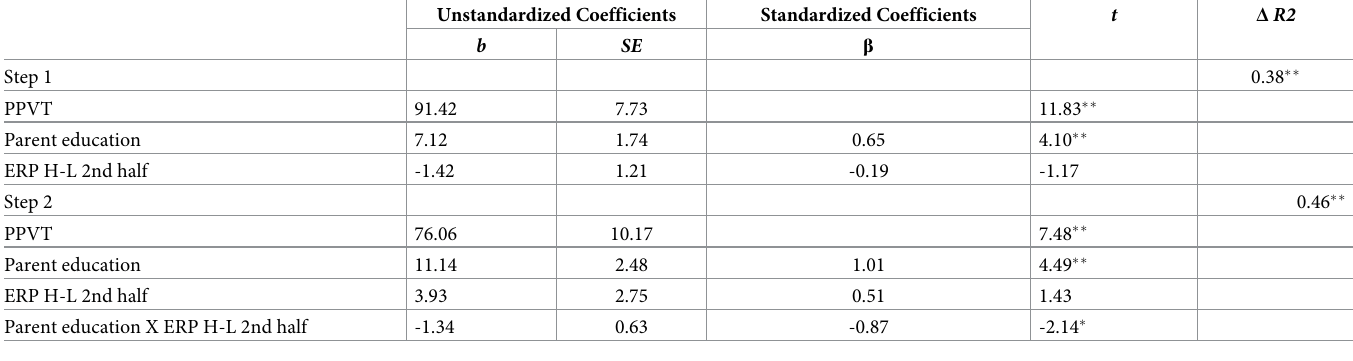
Table 3. Hierarchical regression analysis of the moderating effect of statistical learning (ERPs) on the relationship between parental education average and PPVT scores. Unstandardized